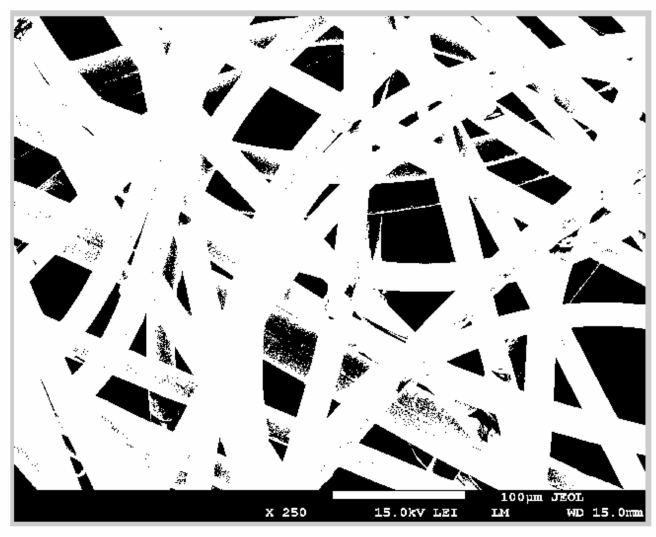
Figure 4. Binary